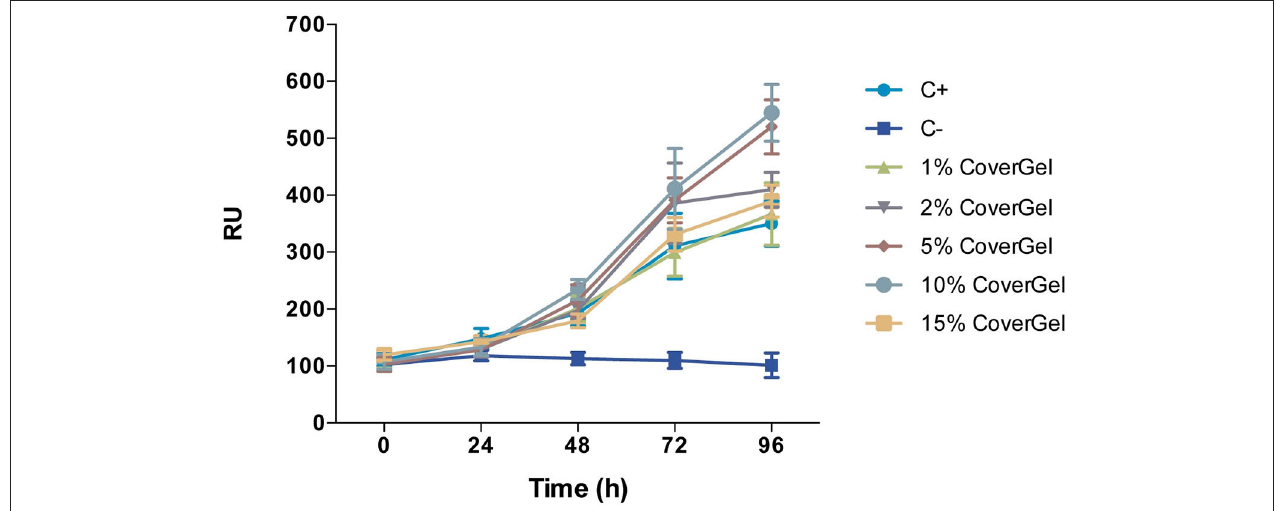
FIGURE 3 | Cell viability of Caco-2 cells in conditioned medium with 1, 2, 5, 10, and 15% of CoverGel. Cells were cultured at 37 ◦ C and 5% CO 2 for 24, 48, 72, and 96h. Values are expressed in Relative Fluorescence Units (RFU).